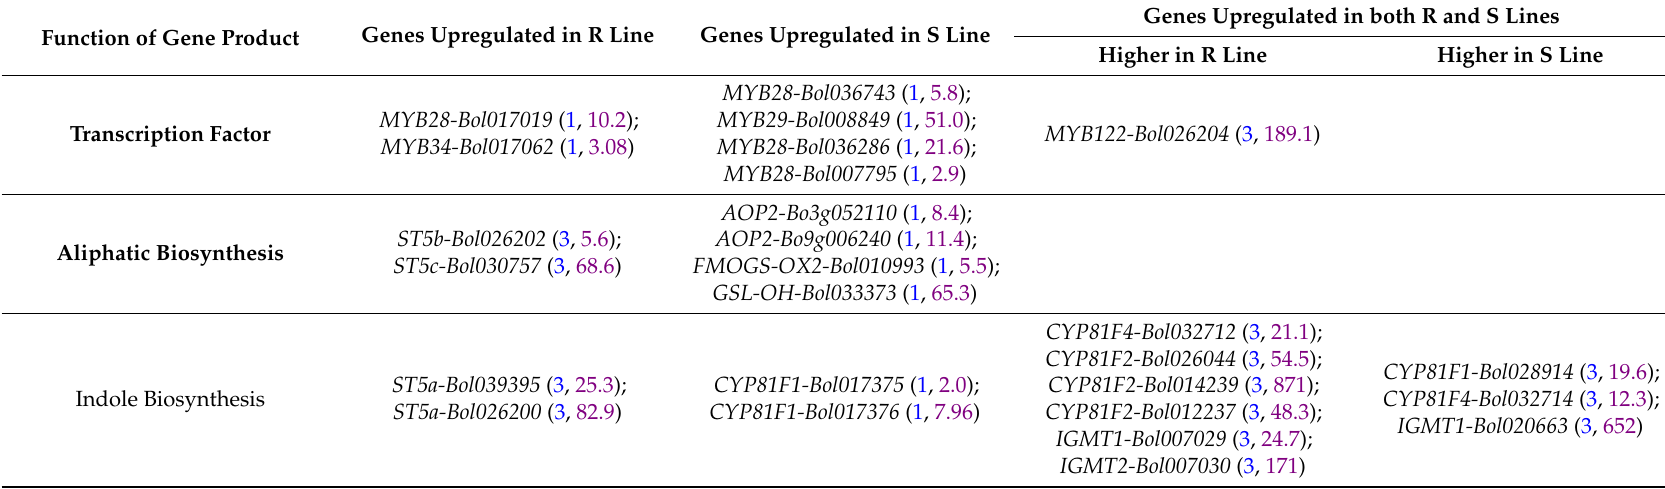
Table 1. Differential expression of genes related to the glucosinolate biosynthesis pathway in white-mold-inoculated R and S cabbage. Numbers in blue and purple color letter indicate days at which genes were expressed and fold differences compare to mock-treated plants, respectively. R, resistant (SCNU-C-049); S, susceptible